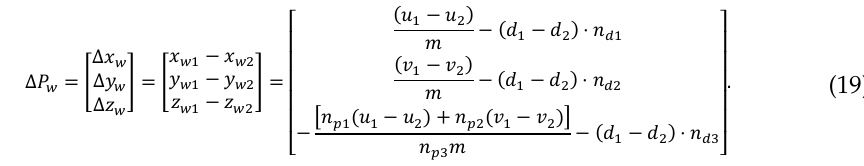
0.6(cid:4666) µ m(cid:4667), Δ 𝑑 (cid:3409) 20 mm 0.02 × Δ 𝑑 + 0.2,20 (cid:3407) Δ 𝑑 (cid:3409) 40 mm .